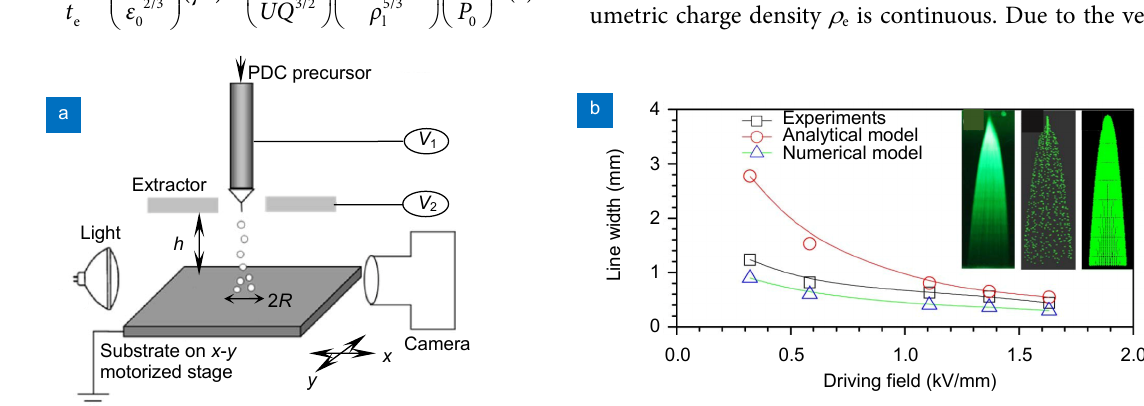
Fig. 2 | (a) Electrospray printing setup with three-electrode configuration (emitter, extractor, and ground). (b) Effect of driving field on line width. Inset: electrospray profile images from (left) experiments, (middle) Lagrangian model simulation, and (right) analytical model (Equation (12)) 21